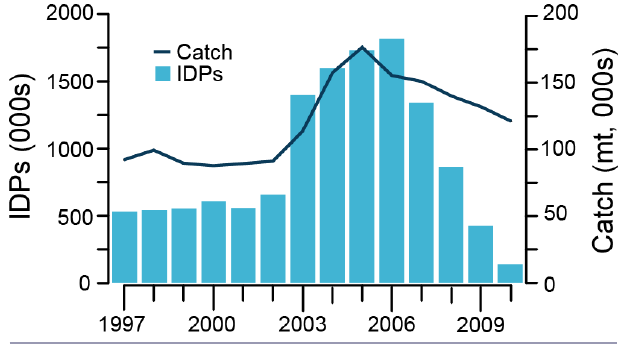
Fig. 2 . The numbers of internally displaced persons (IDPs) in Uganda, largely resulting from the conflict in northern Uganda with the Lord’s Resistance Army, is strongly correlated with catch of Nile perch by Ugandan fishers (contemporaneous r = 0.75; one-year lag r = 0.89; both p < 0.05). This observation is in line with our theoretical priors and has guided our case study. Catch data are from FAO Fishstat (2015). The IDP data are from the Norwegian Refugee Council and Internal Displacement Monitoring Centre (2012). Data from 1998 are interpolated from 1997-1999.